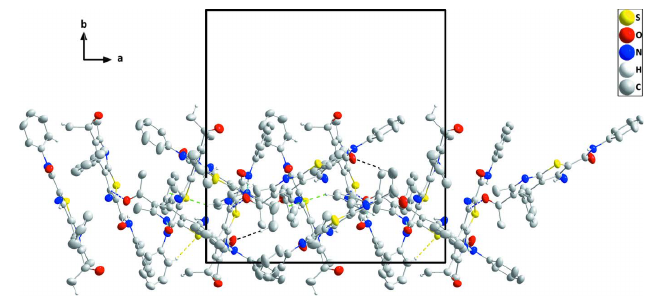
Figure 4 Packing in the crystal of ( I ) viewed along the b axis direction. N—H (cid:2)(cid:2)(cid:2) O, C—H (cid:2)(cid:2)(cid:2) O, N—H (cid:2)(cid:2)(cid:2) N and C—H (cid:2)(cid:2)(cid:2) S hydrogen bonds are depicted, respectively, by dark blue, black, light blue and yellow dashed lines. The C—H (cid:2)(cid:2)(cid:2) (cid:2) (ring) interactions are illustrated by green dashed lines.